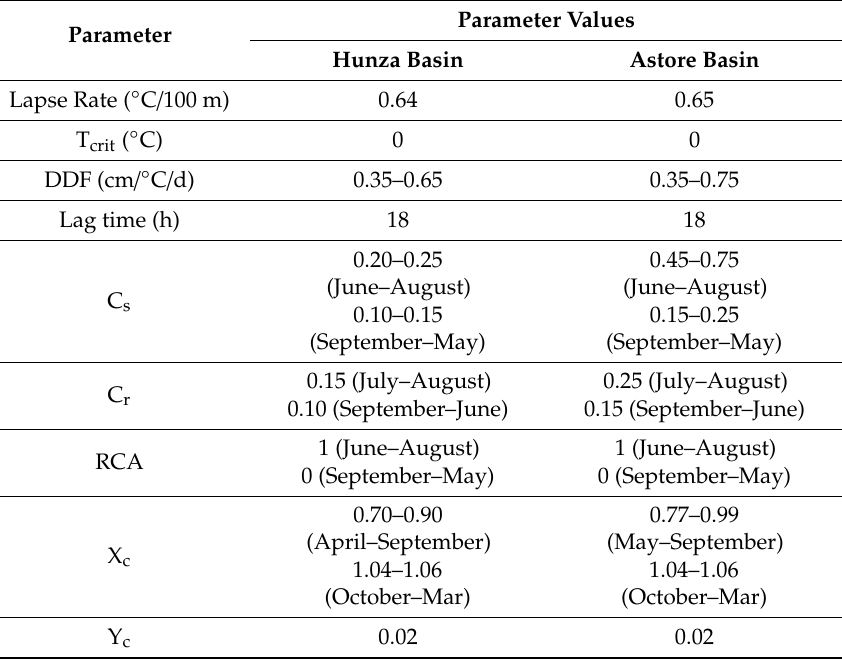
Table 4. Parametric values used in basin-wide application of SRM for the study area. Parameter Values Parameter Hunza Basin Astore